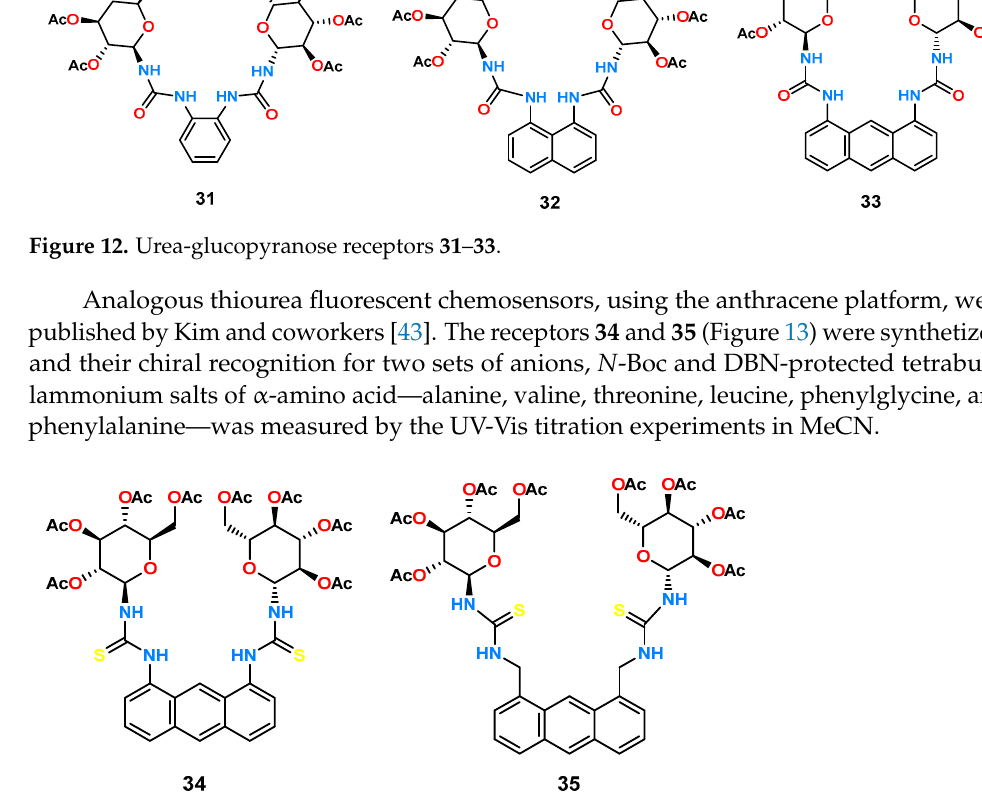
Figure 12. Urea-glucopyranose receptors 31 – 33 .